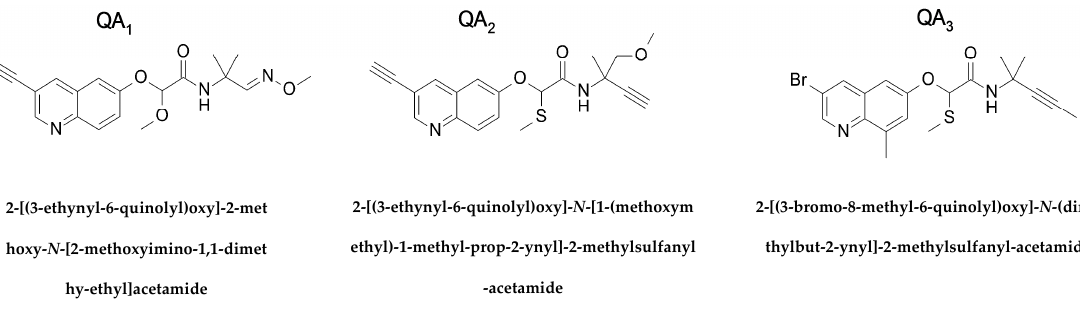
Figure 1. Chemical structures of the quinolin-6-yloxyacetamides compounds used in this study.